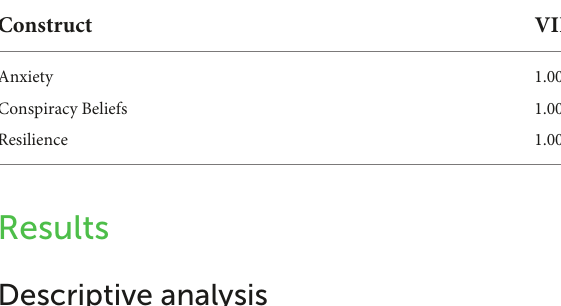
TABLE 4 Discriminant validity—HTMT.